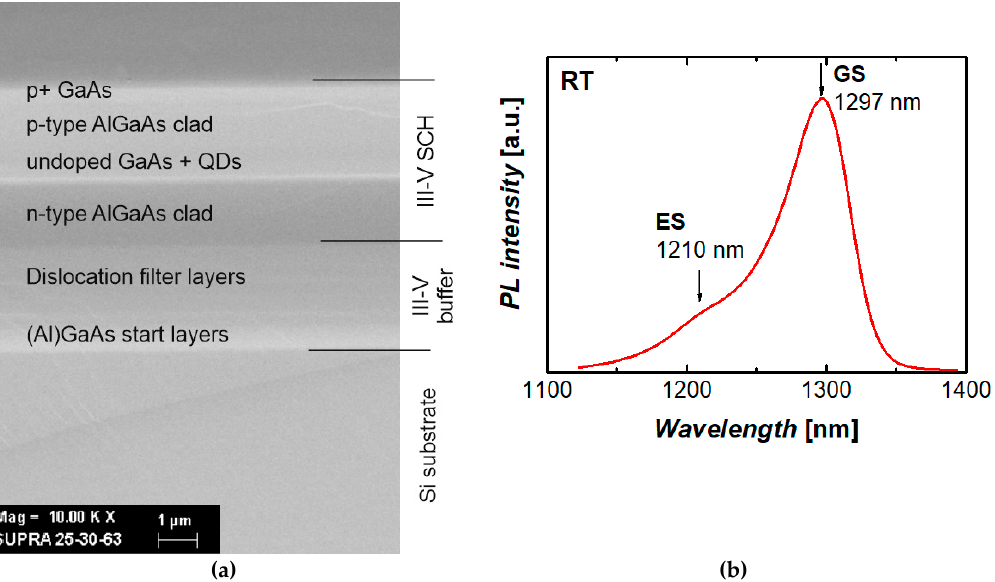
Figure 1. Scanning electron microscopy image of the cross-section of the III–V laser heterostructure grown on silicon ( a ) and representative photoluminescence spectrum of a quantum-dot (QD) test sample grown on silicon ( b ). GS and ES mean ground- and excited-state optical transitions, respectively. A laser structure grown over the bu ff er represents a conventional separate-confinement heterostructure (SCH) with a ~0.43 µ m thick undoped waveguide / active region sandwiched between 1.4 µ m thick n - and p -type Al 0.4 Ga 0.6 As claddings. The active region was formed by seven planes of dot-in-well structures [31], each comprising 2 nm of In 0.18 Ga 0.82 As, 2.7 monolayers of InAs, and 6